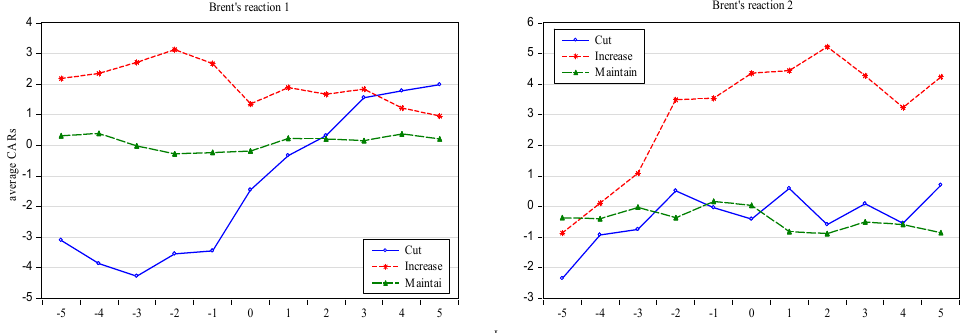
Figure 4. Average CARs of Brent spot price for OPEC’s announcements during two periods. Brent’s reaction 1 refers to the oil price reaction during pre-crisis periods, whereas Brent’s reaction 2 represents the price reaction during post-crisis periods.